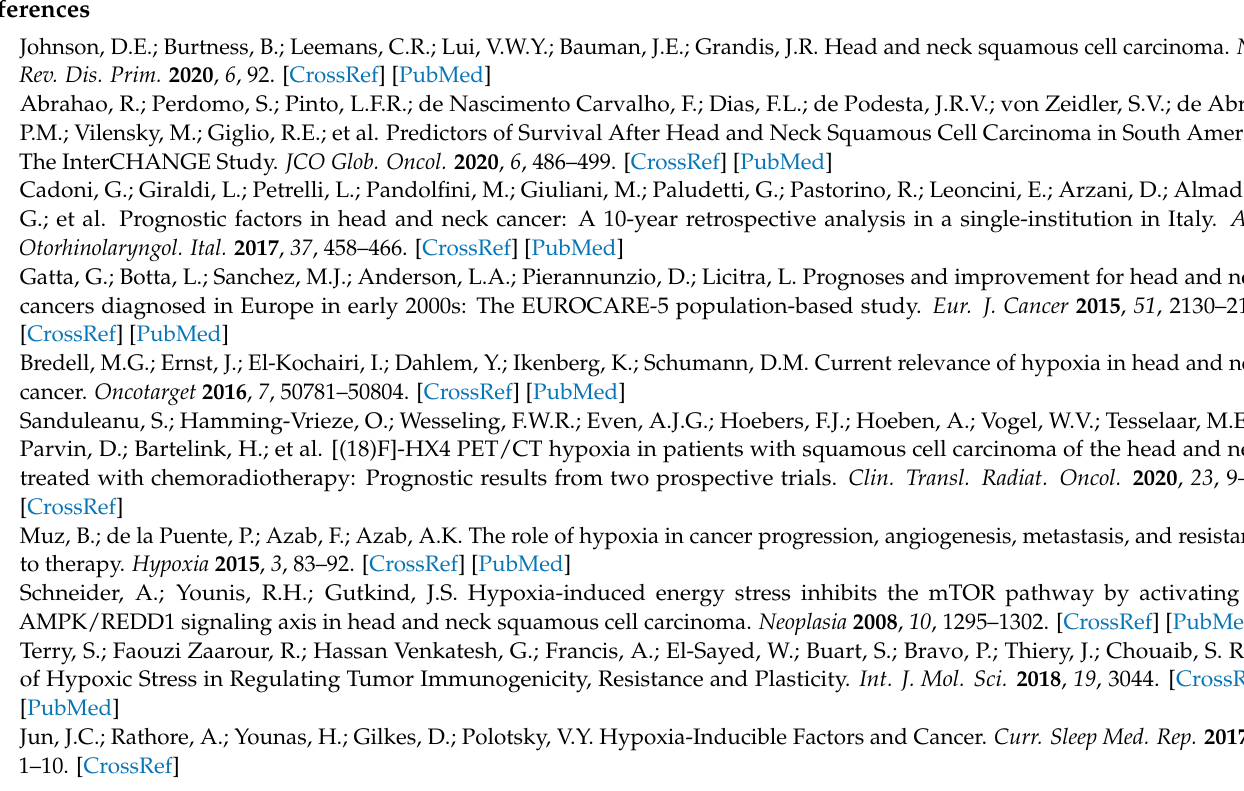
visualization based on Brownian motions, Figure S2: Whole blot image of CD63 western blot shown in Figure 1C, Figure S3: Whole blot image of CD9 western blot shown in Figure 1C, Figure S4: Whole blot image of Grp94 western blot shown in Figure 1C, Table S1: Overview of the selected HNSCC cell lines with regards to anatomical sites of origin, estimated incidence, clinical and molecular characteristics concerning response to anti-angiogenic therapies, Table S2. Profile of all proteins in indicated degrees of